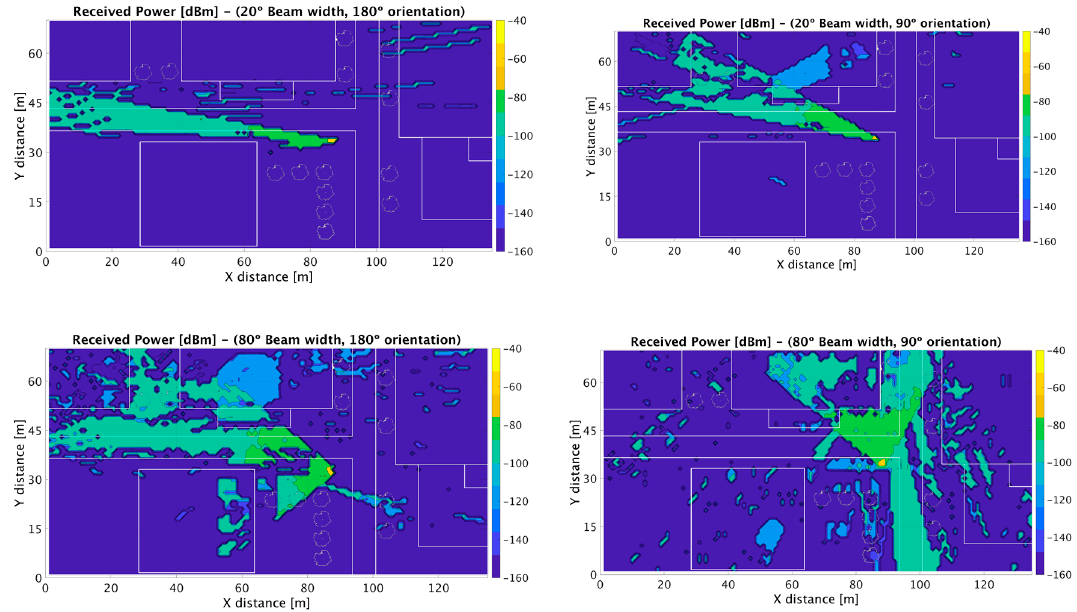
Figure 6. Simulated mmWave power distribution for outdoor coverage (at 28 GHz, beam width values of 80° and 20°, with 180° and 90° orientation), under simulation parameters defined in Table 2.